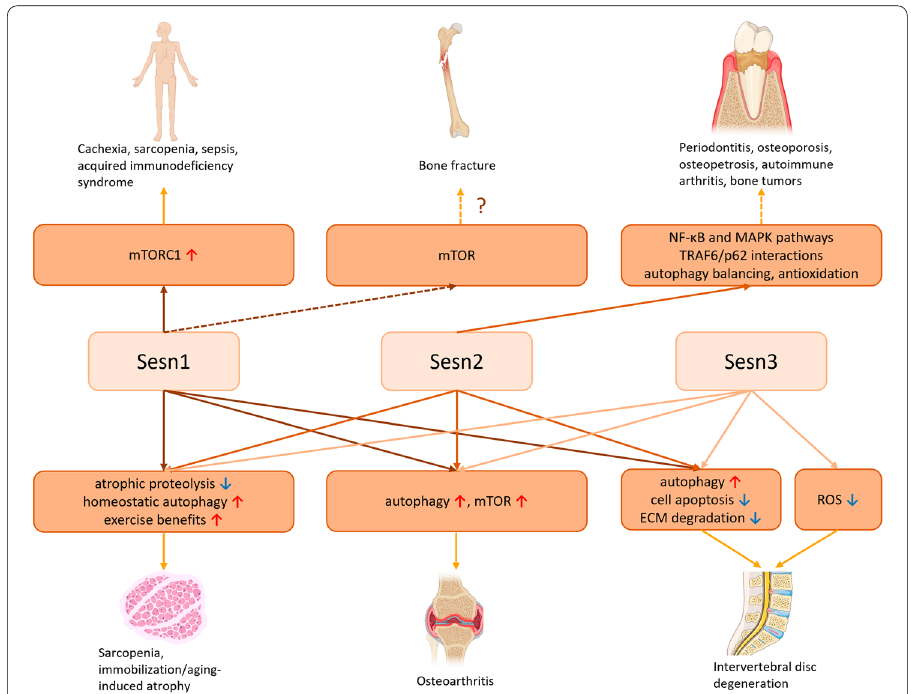
Fig. 2 Functions of Sesns in musculoskeletal system diseases. Sesns play important protective roles in multiple musculoskeletal system diseases, such as diseases related to muscle atrophy, bone and skeletal disorders related to osteoclasts, osteoarthritis, intervertebral disc degeneration, etc. The role of Sesns in bone fracture is unproved. The red up arrows represent activation, while the blue down arrows represent inhibition in this figure. Sesns, sestrins; mTOR, mammalian target of rapamycin; mTORC1, mechanistic target of rapamycin complex 1; MAPK, mitogen-activated protein kinase; TRAF6, TNF receptor associated factor 6; NK-κB, nuclear factor kappa-light-chain-enhancer of activated B cells; ECM, extracellular